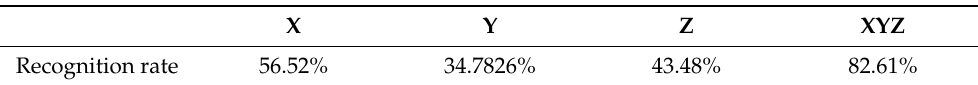
Figure 12. ( a ) Identification results of X-axis color moment eigenvalues; ( b ) identification results of eigenvalues of Y-axis color moments; ( c ) identification results of eigenvalues of Z-axis color moments; ( d ) identification results of X-axis, Y-axis, and Z-axis color moment eigenvalues. Table 7. Recognition rate of test samples.